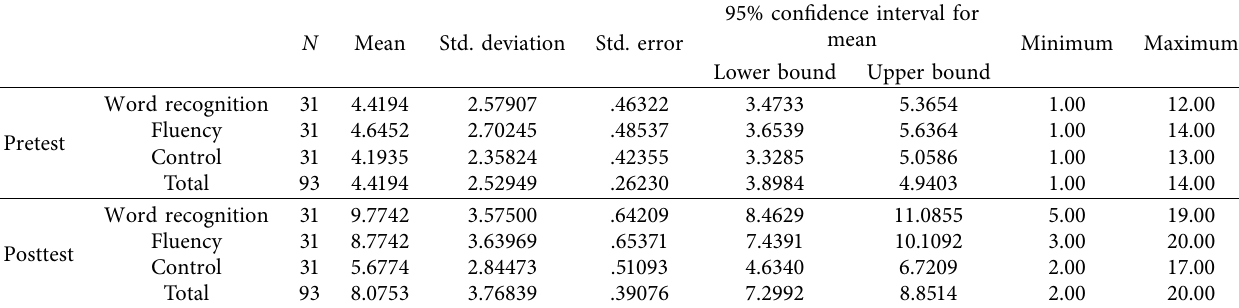
Table 1: Descriptive statistics of all groups on the pre- and posttests.